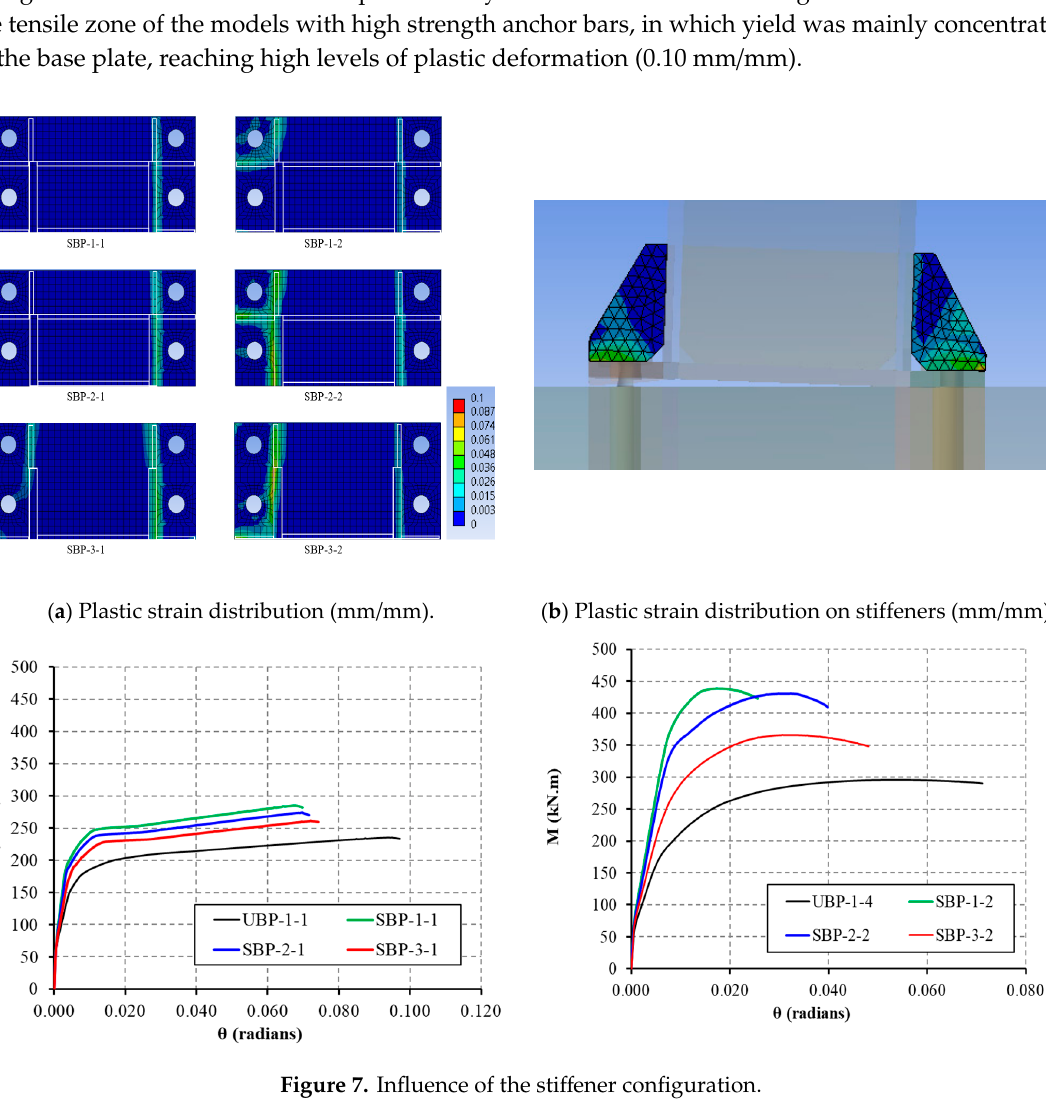
Figure 7. Influence of the stiffener configuration.